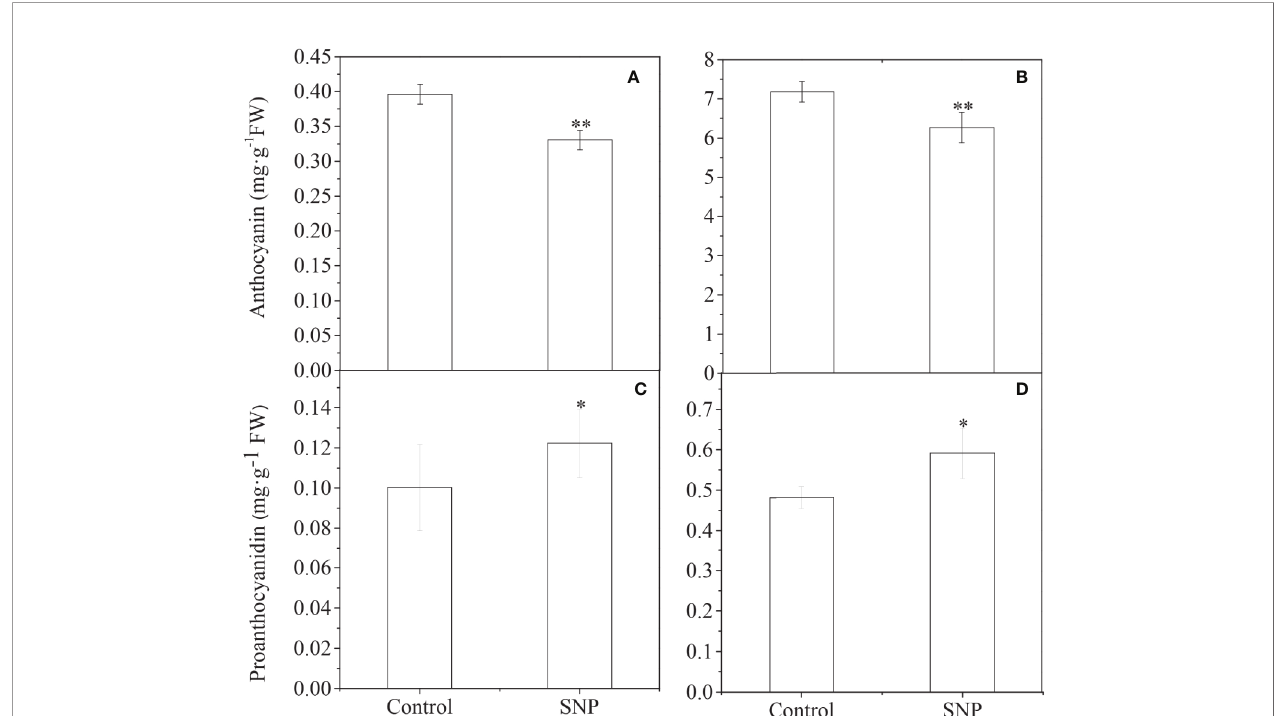
FIGURE 7 | Effect of exogenous SNP application on anthocyanin and PA accumulation in Lycium fruits. 1 mM SNP (soluted in 0.05% Tween 20) was utilized to spray the green stage fruits (S2) of YF and BF, on a sunny day after the sun went down. Fruits were sprayed with only a 0.05% Tween 20 solution as a control. After 15 days, the mature fruits (S5) were sampled to measure anthocyanin (A, B) and PA (C, D) content for both of YF (A, C) and BF (B, D) , respectively. The data show the means ± SDs (n = 3). The asterisks on the bars for the same species indicate signi fi cant differences between the treatments. “ * ” indicates p < 0.05, and “ ** ” indicates p <